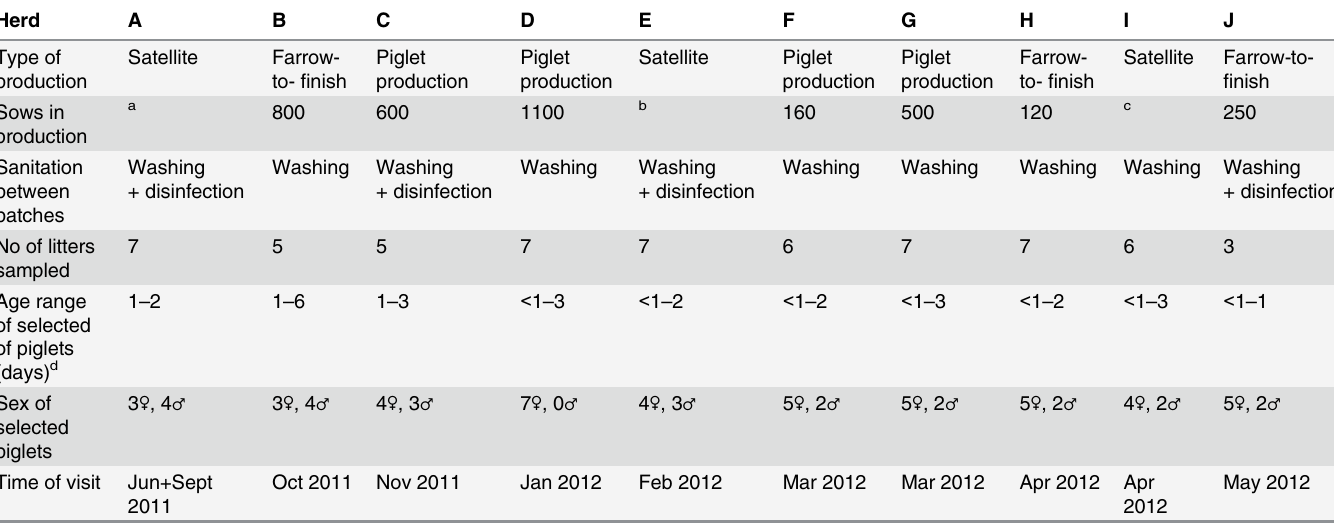
Table 1. Descriptive data on selected herds (n = 10, A-J) and piglets (n =